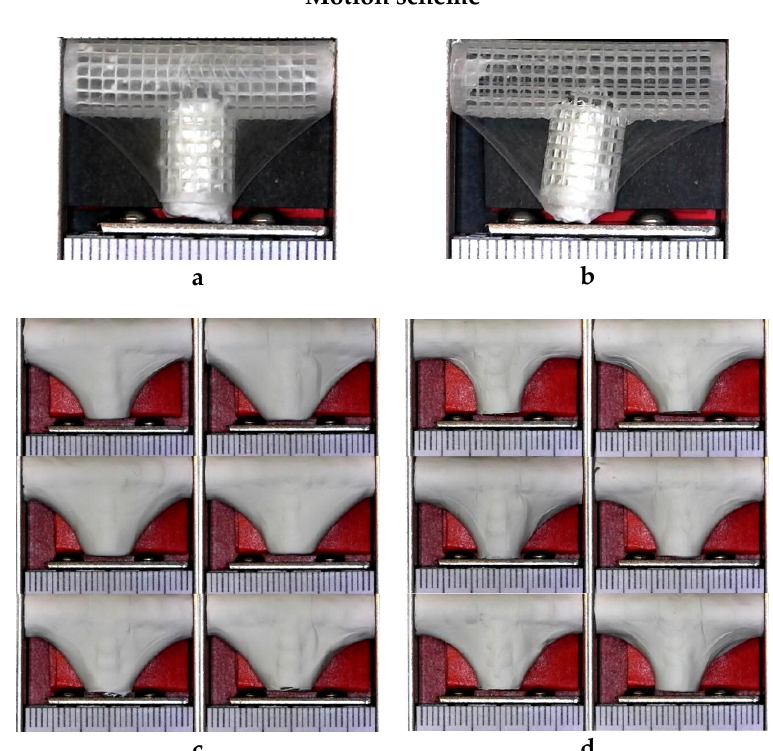
Figure 13. Overview of bifurcated vascular grafts obtained under di ff erent sets of process parameters. ( a ) Rotational (BLSP_SC_R); ( b ) Rotational and longitudinal (BLSP_SC_RL); ( c ) Rotational (BLSP_CC_R); ( d ) Rotational and longitudinal